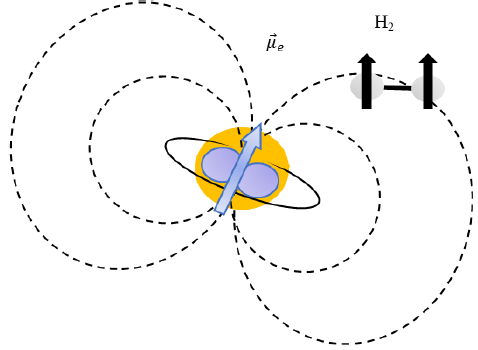
Fig. 4. Hydrogen conversion on para-magnetic surfaces: magnetic impurity dipole field.